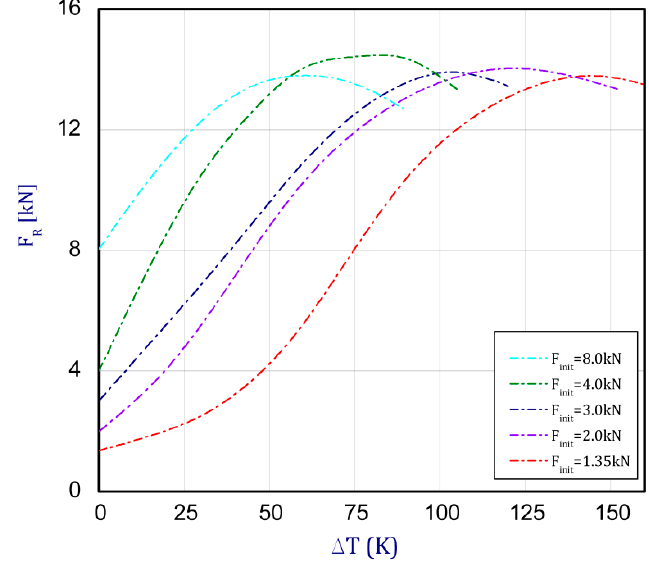
Figure 8. The force reaction vs. the temperature increment for different preloads obtained by EXP.